Question: Produce a descriptive caption suitable for publication.
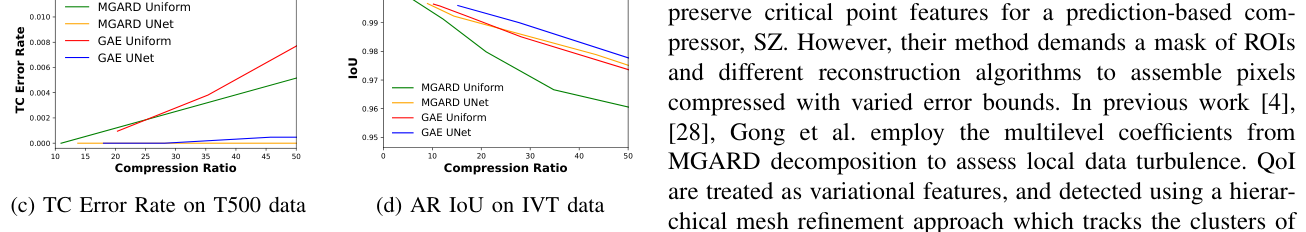
Answer: QoI error for TC and AR. These results show that GAE with UNet is able to achieve higher compression ratio while achieving comparable or better accuracy to other methods.